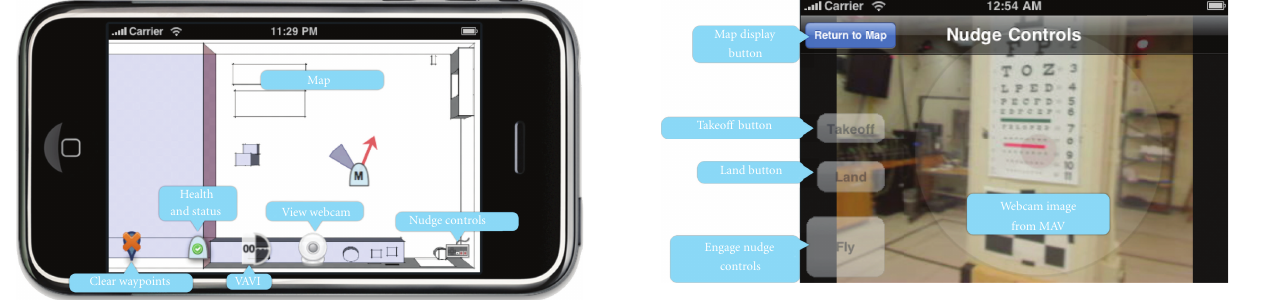
Figure 1: The map display and general interface of MAV-VUE.